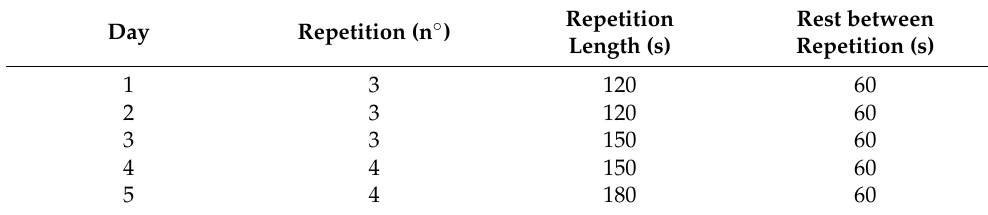
Table 2. Dosage of the virtual reality exercises for the first week of home